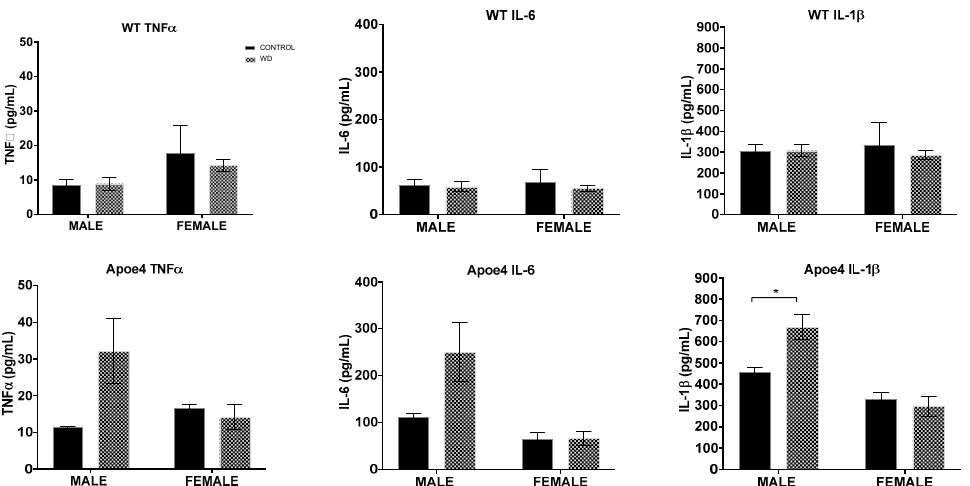
Figure 6. Chronic inflammatory cytokines in the brain. Expression of inflammatory cytokines was measured by ELISA. No effect of high-fat diet is evident in WT in any of the cytokines. In contrast, male (but not female) ApoE4 mice showed a significant increase in IL-1 β in response to chronic exposure to the high-fat diet. * p < 0.05 . 2.6. Behavioral Testing Reveals Impairments from WD in Genotype Are Moderated by Sex